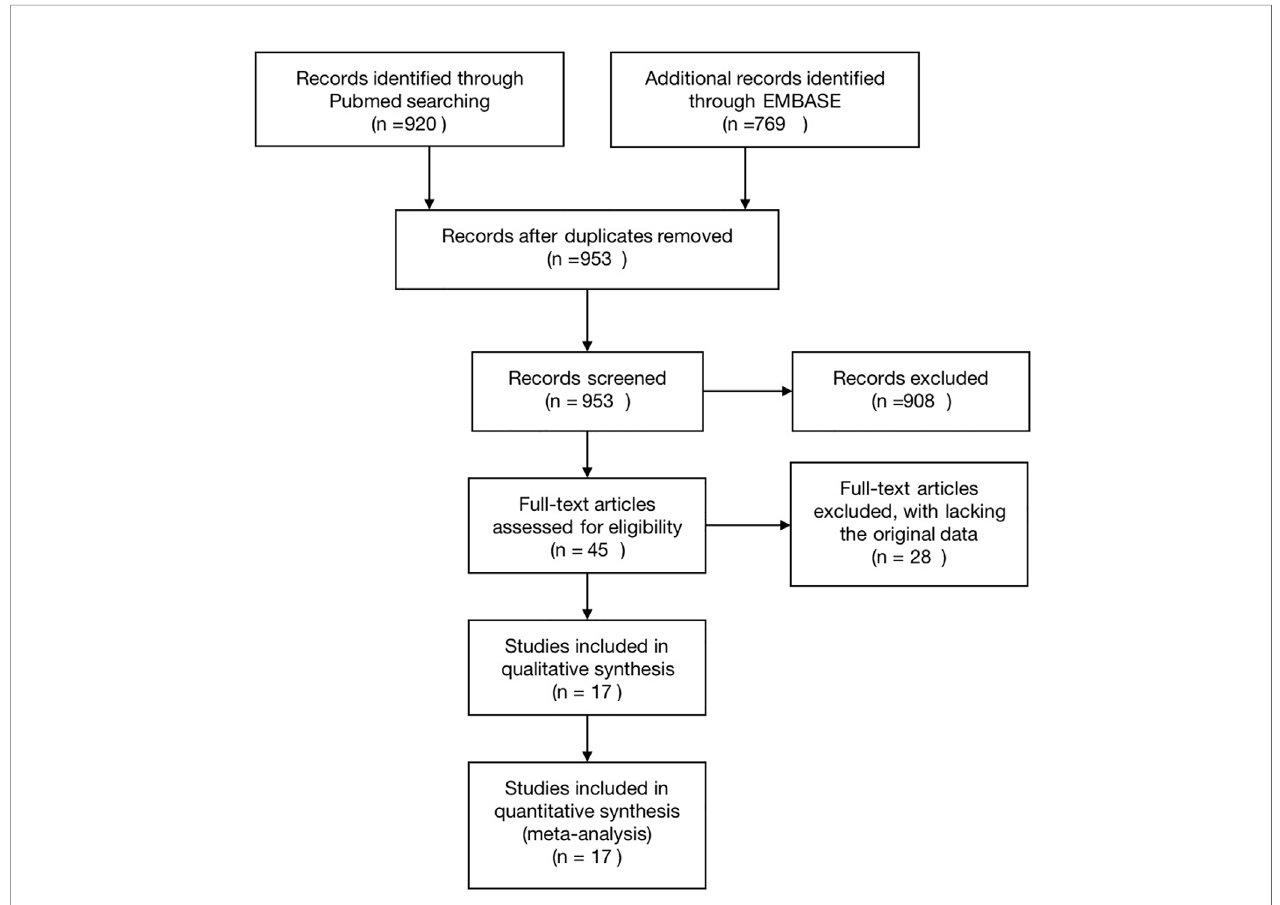
FIGURE 1 | Flowchart explaining the article